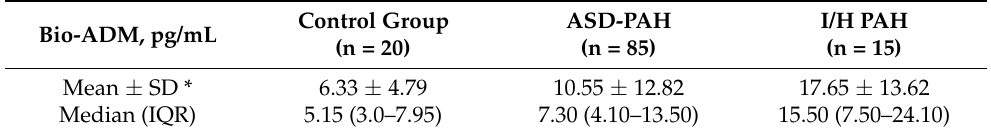
Table 2. The bio-ADM (pg/mL) levels among subjects with ASD without PH (control group), ASD-PAH and I/H- PAH.